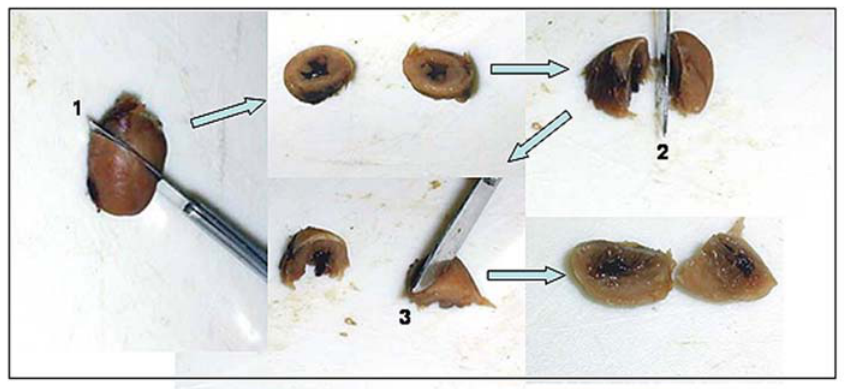
Fig. 8 – Generalization of the orientator method in rat heart preparation. First, the heart is cut at random (1) and after the two halves are put on this face and cut again at random (2), and again (3). This last face has no more information about the structural arrangement of the structure and can be considered isotropic and uniformly